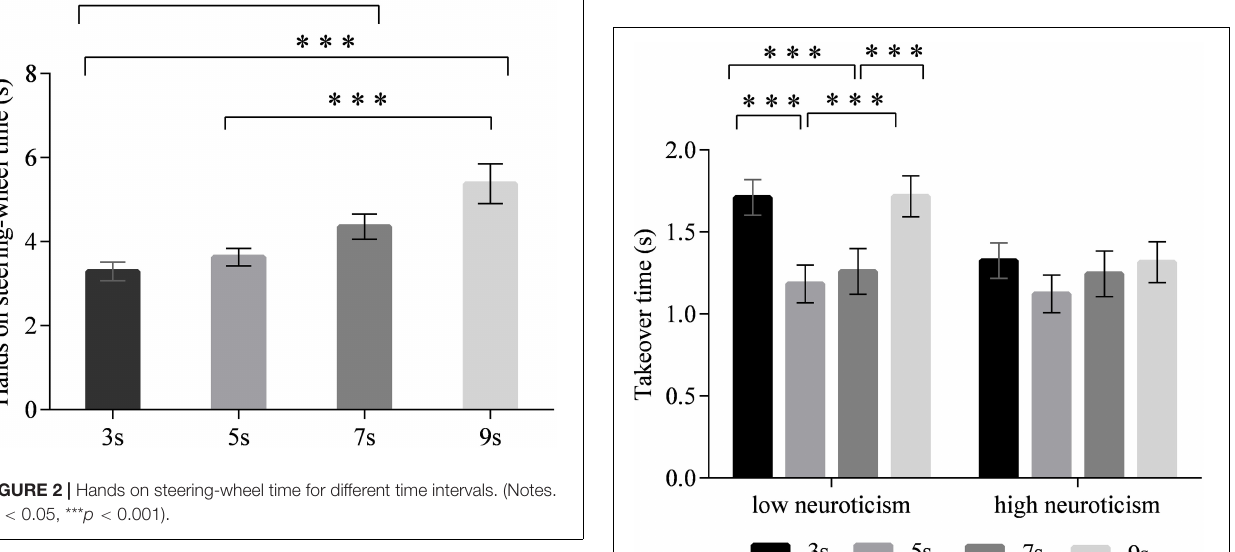
under both the 3- and 9-s time intervals, the drivers with high neuroticism had longer takeover times than the drivers with low neuroticism ( p < 0.05). In comparison, there were no significant differences between two driver groups under the 5- and 7-s time intervals ( Figure 5 ). The main effect of neuroticism on the takeover time was not significant [ F ( 1 , 30 ) = 2.477, p = 0.125].